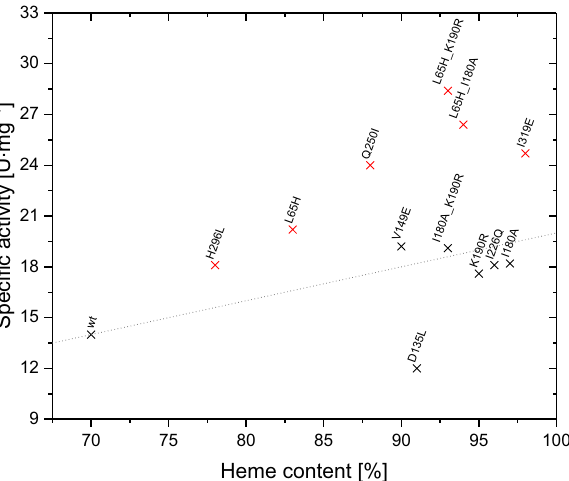
Figure 6. Correlation of the estimated heme content of selected OxdB variants and their specific activity. The dotted line refers to a linear dependence of the specific activity and the heme content compared to the wild-type